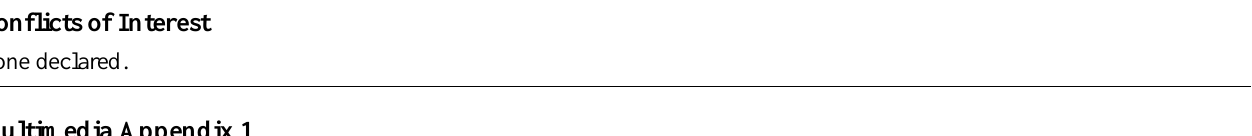
Table S1. Full list of Twitter chat responses from participants regarding barriers to care for metastatic breast cancer and potential policy